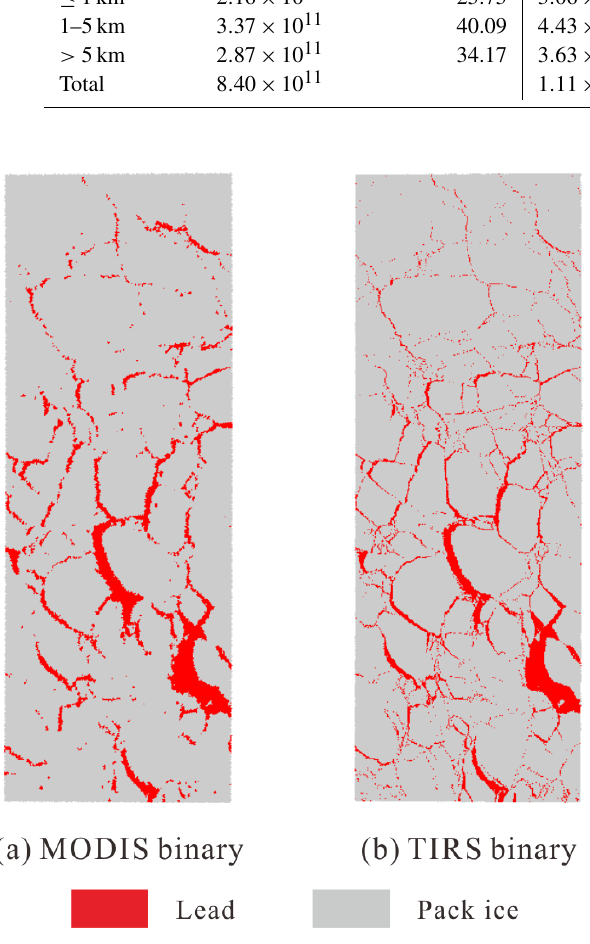
Figure 9. Binary lead maps from (a) MODIS and (b) Landsat-8 TIRS.